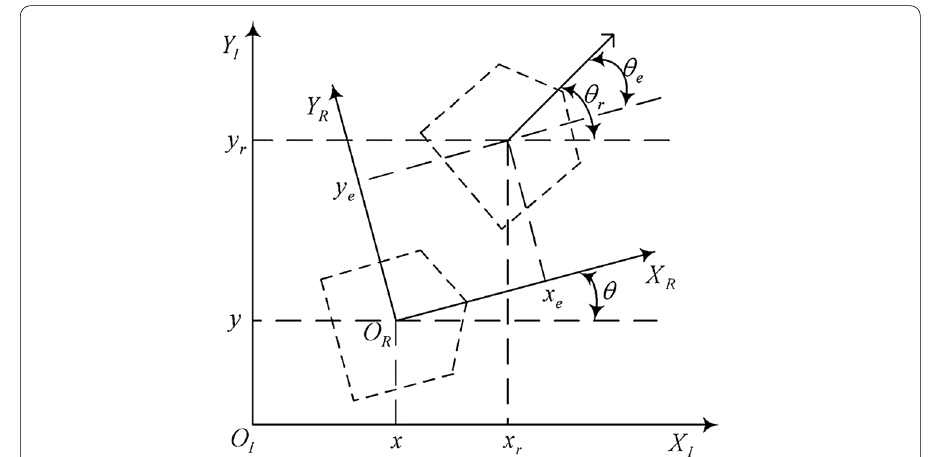
Fig. 1 Schematic diagram of AGV motion